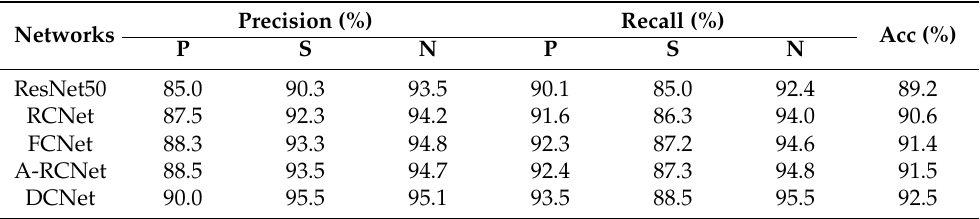
Table 1. Comparison of different detection-classification networks. P, S, and N denote videos of a porn, sexy, and normal class, respectively.